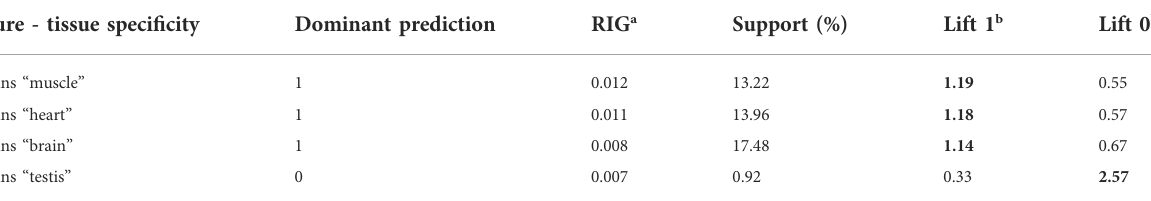
TABLE 3 Tissue speci fi city